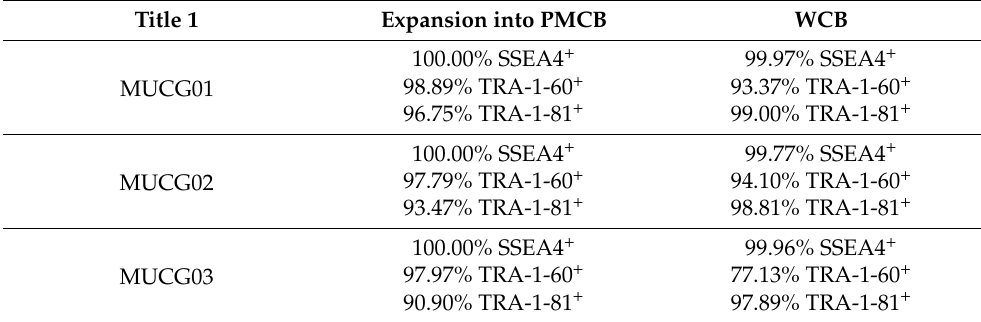
Table 4. Flow cytometry results for the hESC lines MUCG01, MUCG02, and MUCG03. PMCB, pre-master cell bank; WCB, working cell